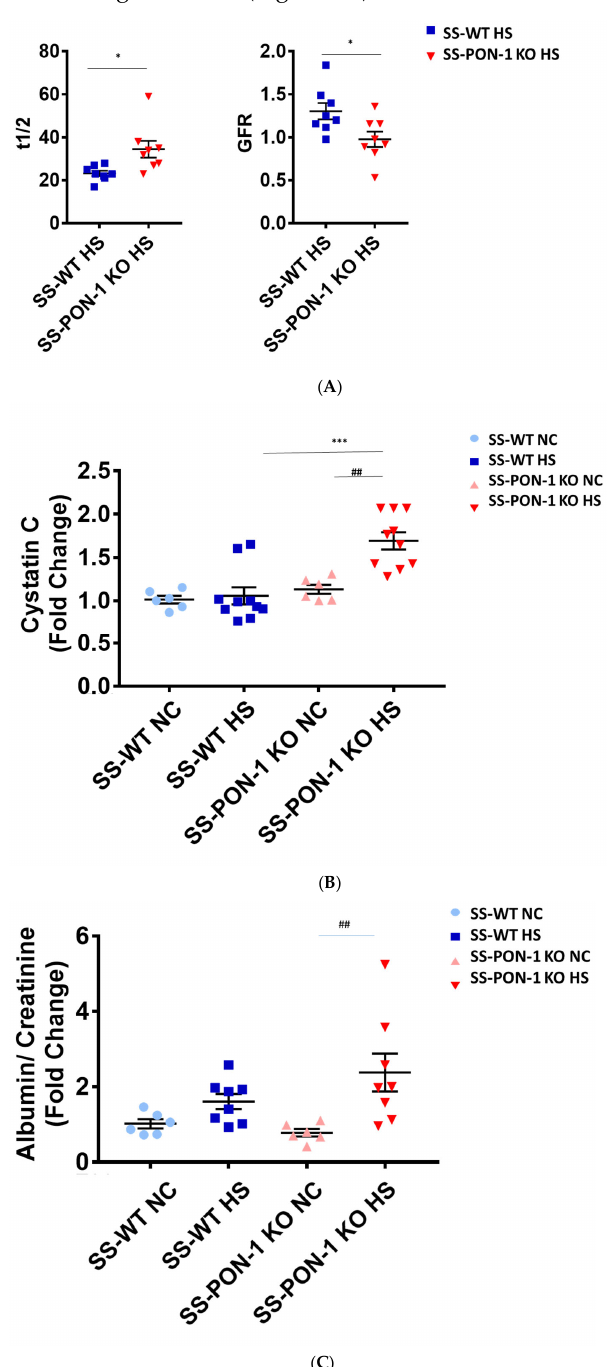
Figure 5. Targeted mutation of paraoxonases ‐ 1 contributes to a decline in renal function as assessed by ( A ) FITC ‐ Sinistrin glomerular filtration rate, ( B ) plasma cystatin C measurement, and ( C ) albu ‐ min urinary excretion. SS ‐ PON ‐ 1 KO rats show a significant decline in renal function compared to SS rats following 5 weeks 8% high ‐ salt diet (HS N = 8, NC N = 6). * p < 0.05, *** p < 0.001 vs. high ‐ salt, ## p < 0.01 vs. normal chow.